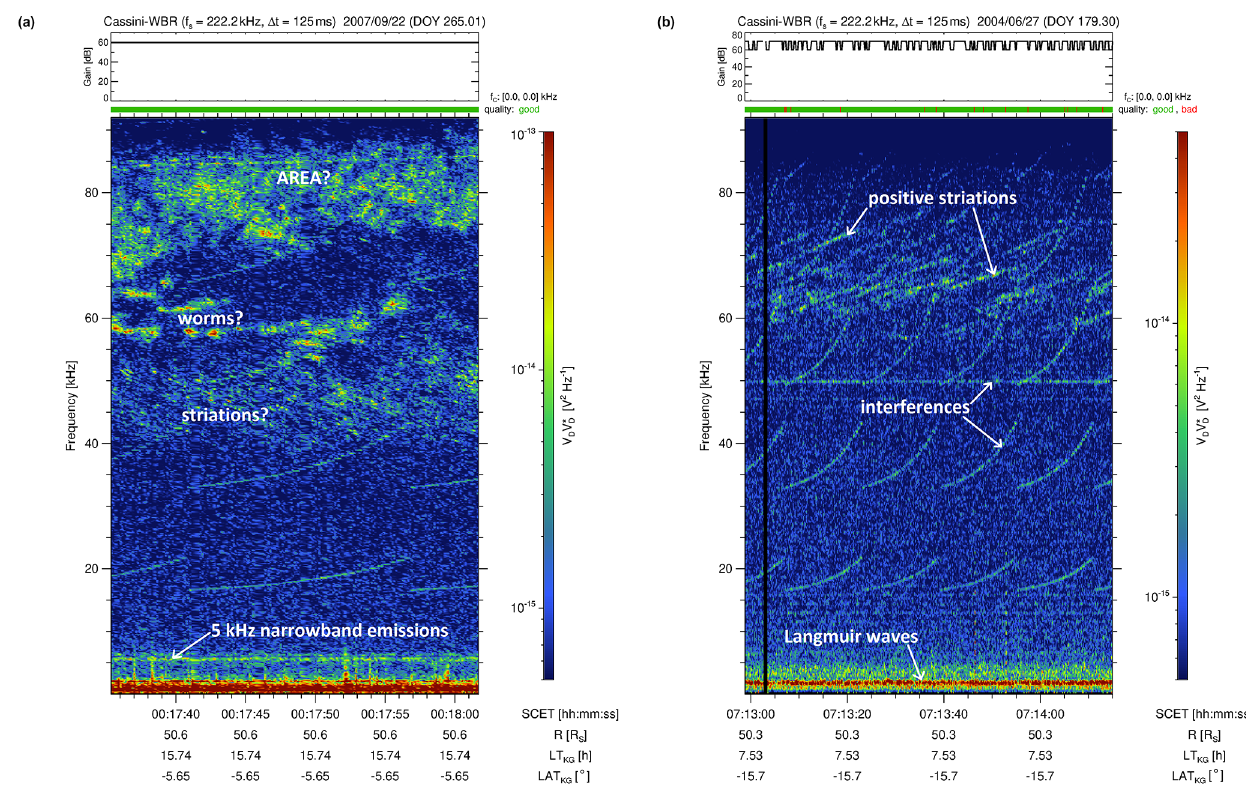
Figure 5. Example of unclassified SKR spectrum in (a) and rare positive striations in (b) .